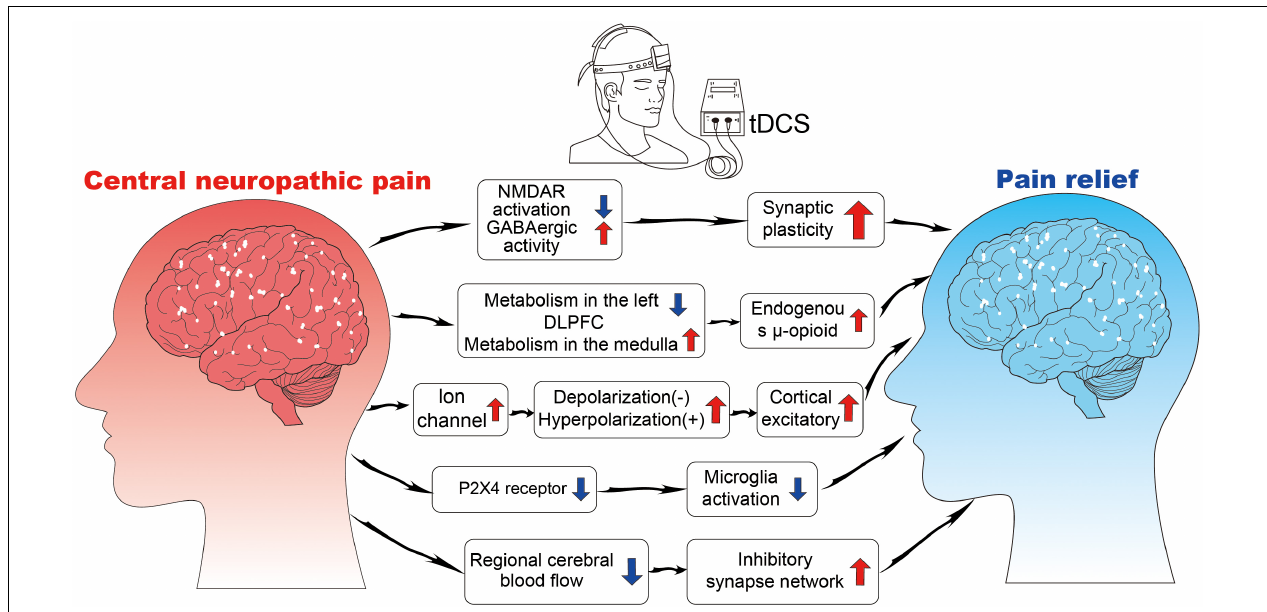
FIGURE 3 | The neurophysiological mechanisms of tDCS. NMDAR, N-methyl-D-aspartate receptor; GABA, gamma-aminobutyric acid; P2X4, purinoceptor